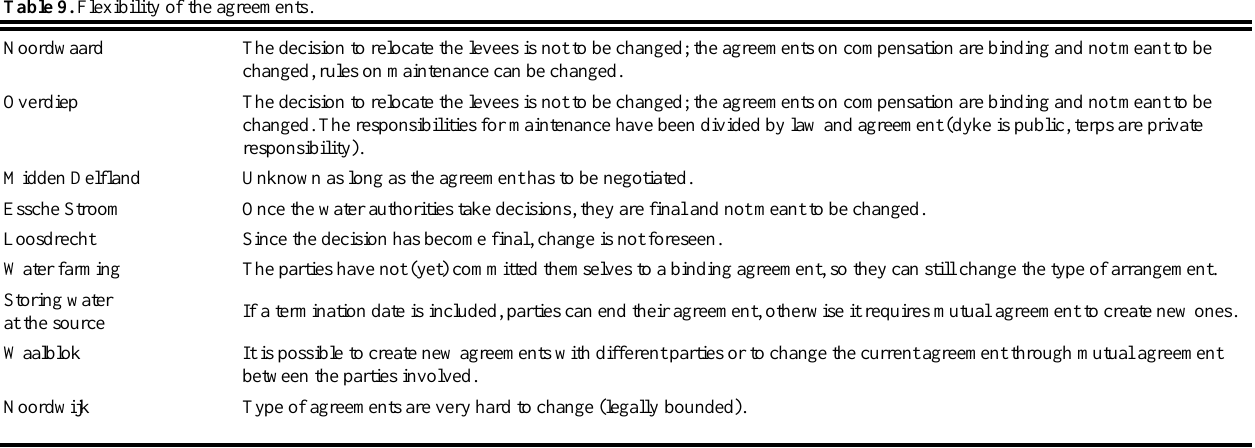
Table 9. Flexibility of the agreements.